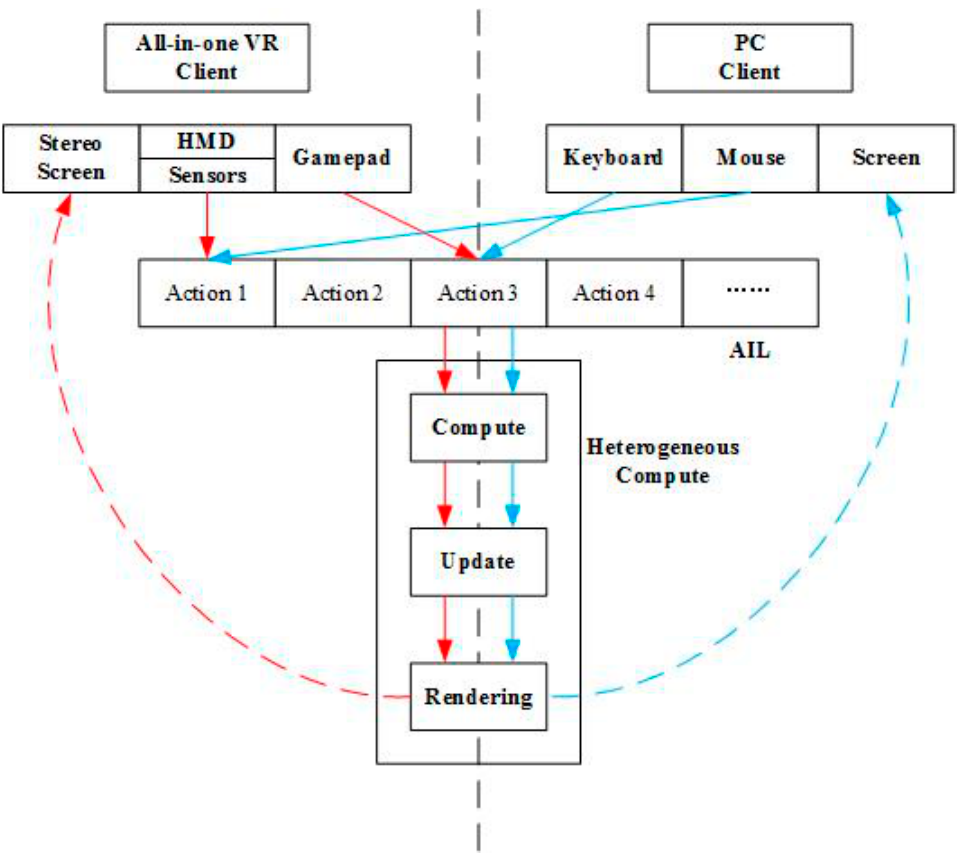
Figure 3. Flow chart of the abstract interaction layer for h eterogeneous clients.